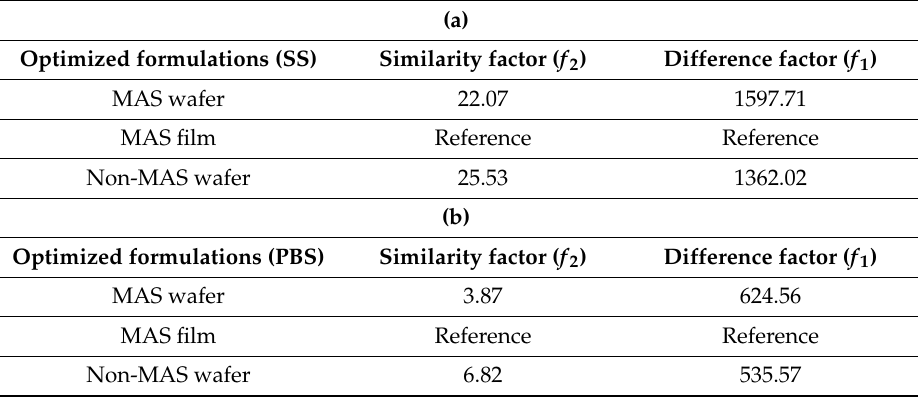
Table 3. Similarity and difference factors for drug release profiles of optimized wafers and films ( a ) between optimized wafers and film in SS and ( b ) between optimized wafers and film in PBS.